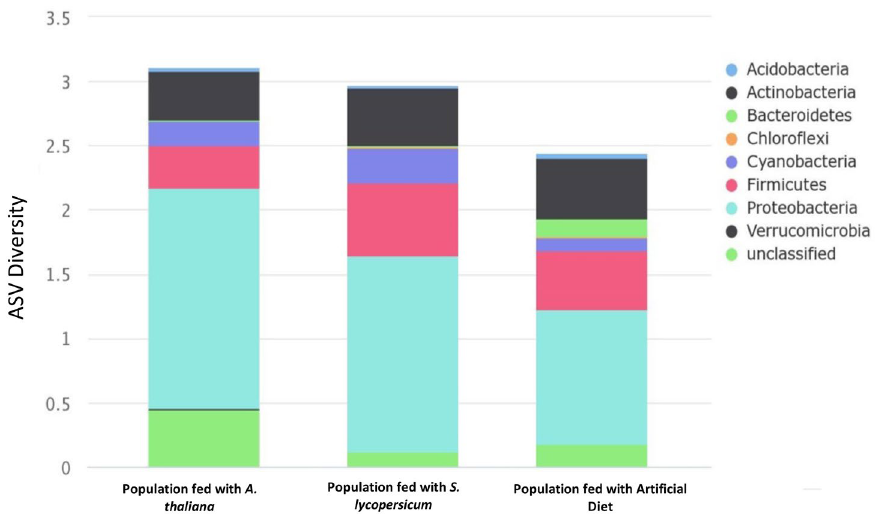
Figure 4. Bacterial phylogenetic diversity of microbiota detected in the guts of Trichoplusia ni populations fed with exclusive diets. Bacterial diversity from each population corresponds the numbers of ASVs classified at the phyla